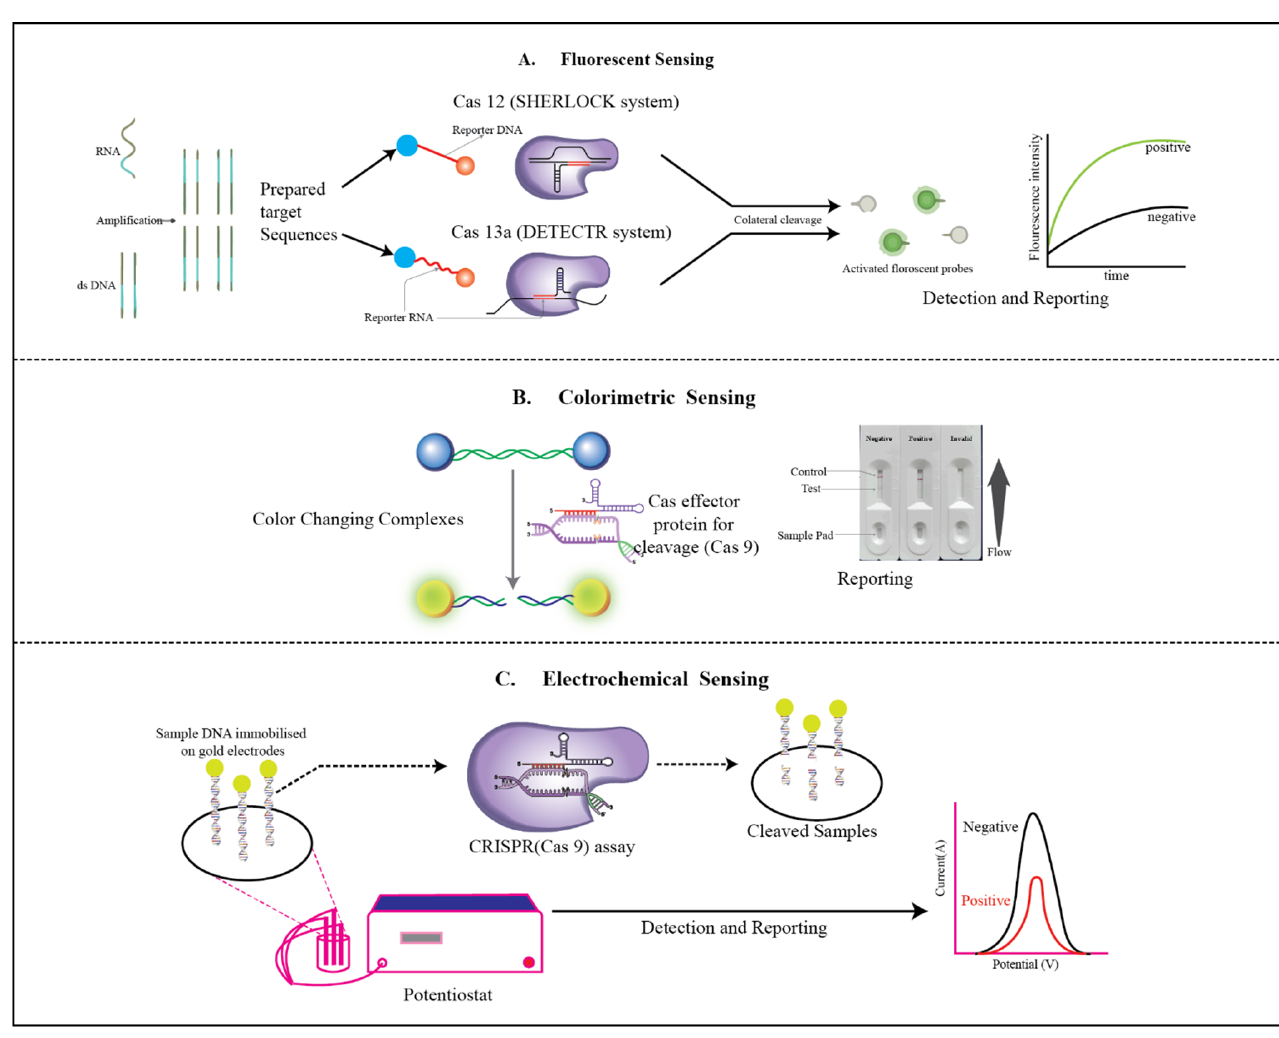
Figure 2. Three widely used signal detection techniques can be monitored to detect the existence of the target gene. ( A ) Fluorescence ‐ based sensing uses target sequences prepared with fluorescent probes to detect target sequences based on the changes in fluorescence intensity. A higher intensity than the control denotes a positive result; examples are SHERLOCK and DETECTR. ( B ) Colorimetric sensing uses color ‐ changing complexes attached to CRISPR ‐ Cas as complexes to detect target sequences. When the complexes are cleaved using targeted the CRISPR assay (Cas ‐ 9), a color change is observed. ( C ) Electrochemical sensing detects the target sequence based on changes in electrical potential using a potentiostat.